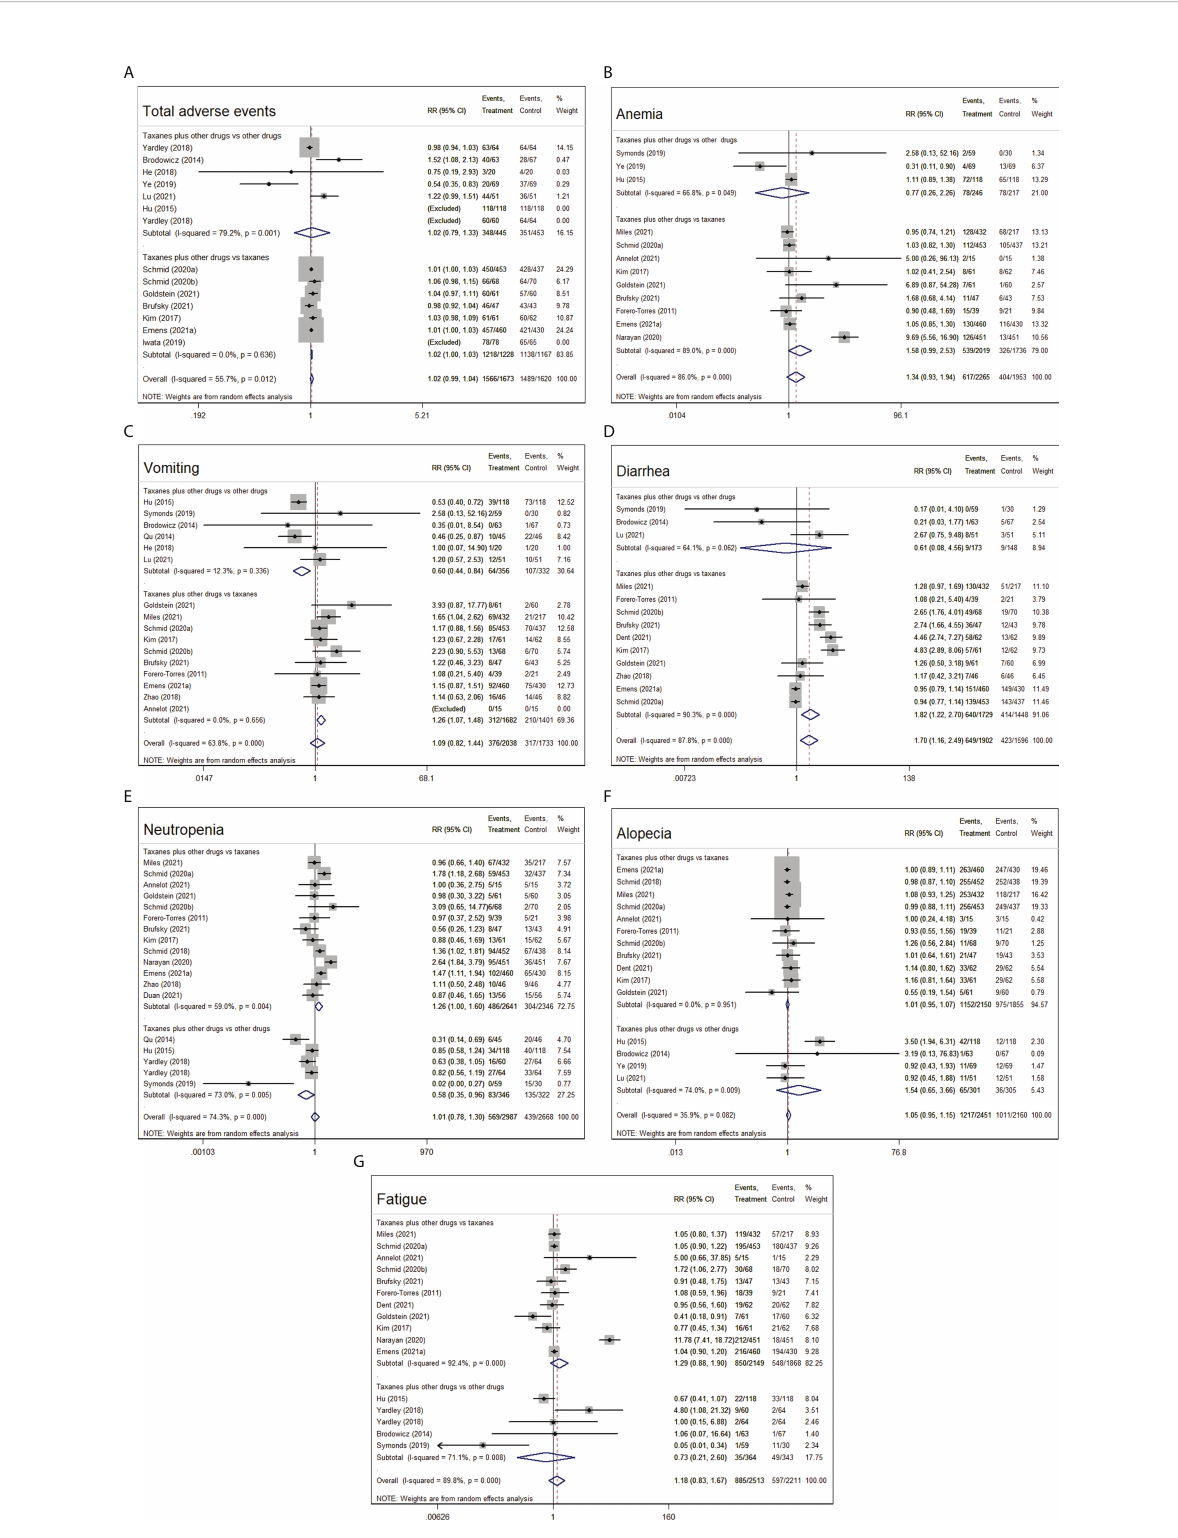
FIGURE 5 Forest plot of randomized controlled trials on taxanes combination therapy for adverse event: total adverse events (A) , anemia (B) , vomiting (C) , diarrhea (D) , neutropenia (E) , alopecia (F) , and fatigue (G)